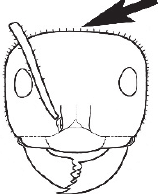
– Short peg-like setae much reduced on antennae and absent from legs; cuticle finely shagreenate and weakly shining; posterior margin of head of minor worker planar; mandible of minor worker coarsely striate (very rare, southern WA; SA) ( JDM 613 ) (Fig. 89a–g) .......................................... barbellulatus